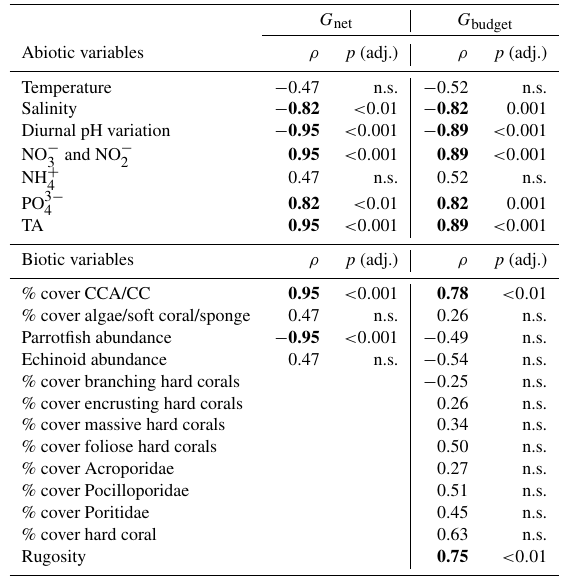
Table 5. Coefficients from Spearman rank order correlations for abiotic and biotic predictor variables vs. G net and G budget . The means of abiotic and biotic variables per reef site were correlated with G net ( = net-accretion/-erosion rates of limestone blocks) and G budget ( = census-based carbonate budgets). Strong and signifi- cant correlations ( ρ values > | 0 . 75 | ) are marked in bold. P -values were adjusted by the Benjamini–Hochberg method. CCA: crustose coralline algae; CC: calcifying